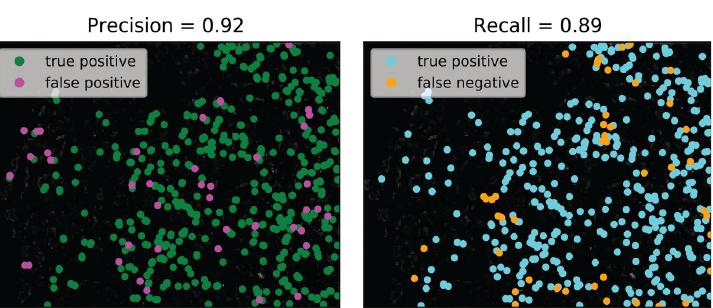
Fig 4. The in situ transcriptomics annotation pipeline was tested using RCA (Rolling Circle Amplification) images from an in situ sequencing (ISS) experiment in the starfish database. Worker consensus annotations for RCA test image ISS_rnd0_ch3_z0, which contains 416 spots, achieved 92% precision and 89% recall based on expert consensus annotations. The Jaccard similarity index (intersection over union) between the consensus annotations and the expert annotations was